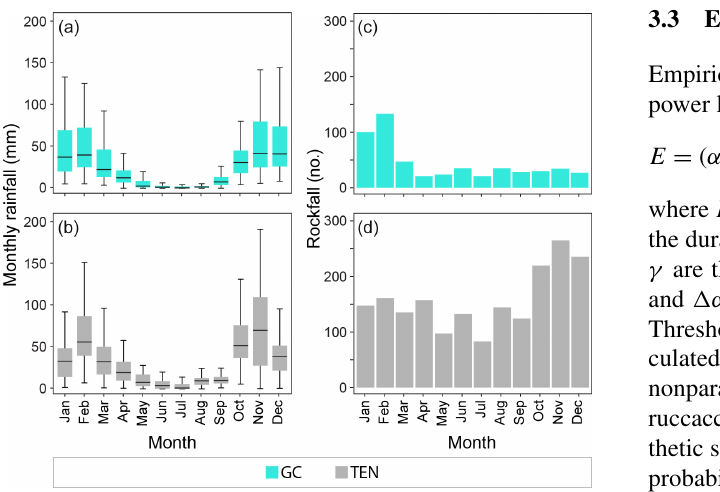
Figure 3. Comparison between monthly rainfall and rockfall oc- currence. (a, b) Annual variation in monthly rainfall measures in GC (cyan) and TEN (gray). The whiskers show 1.5 times the in- terquartile range. (c, d) Number of rockfalls per month in the two test